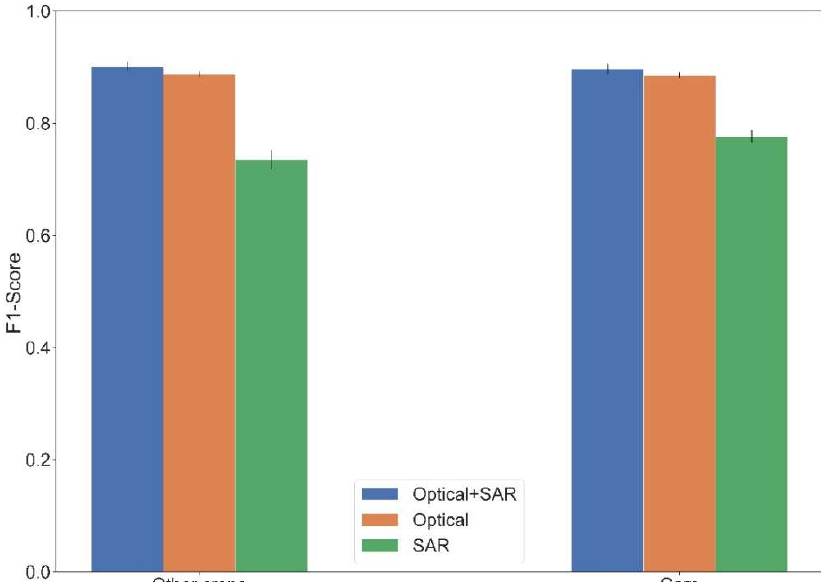
Figure 13. Comparison of F1-Scores among different variable combinations. Three groups of features were tested. Compared with using all of the features as input, one group contains only optical image metric composites, while the other group includes SAR metric composites of the VV and VH bands.